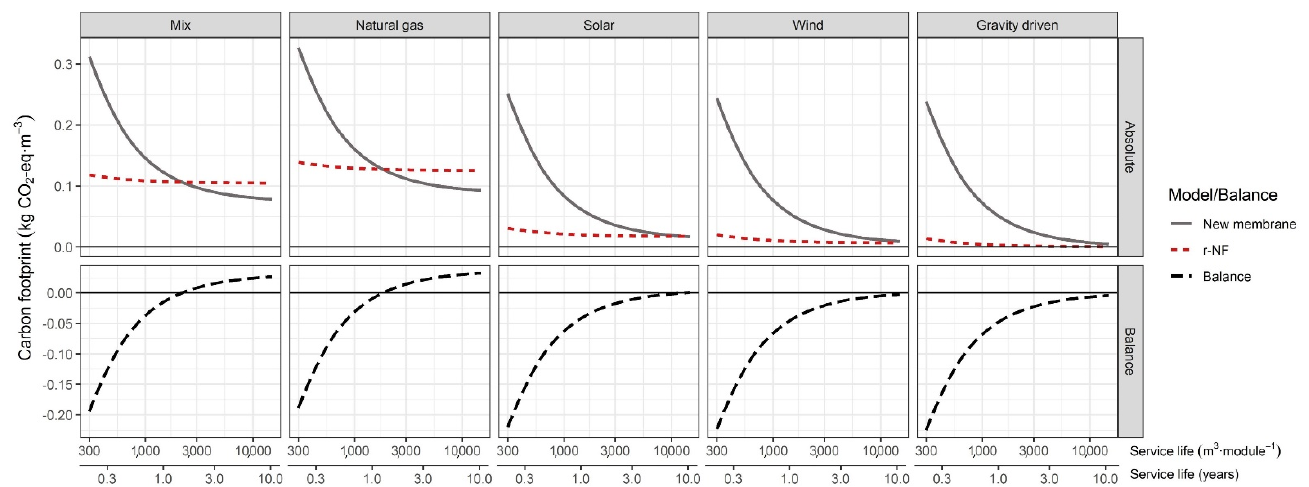
Figure 2. C arbon footprint and balance depending on membrane lifespan under strategy A.